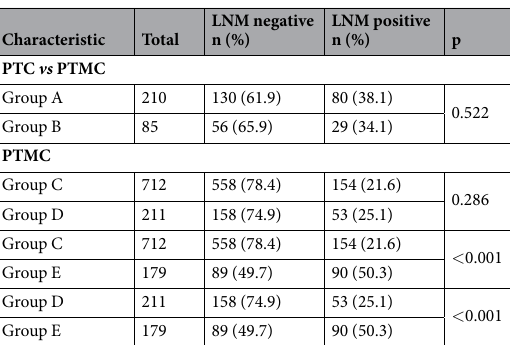
Table 2. Differences in lymph node metastasis between the different tumour size groups. Group A: PTC, unifocal with diameter > 1 cm and ≤ 2 cm; Group B: PTMC multifocal with total tumor diameter (TTD) > 1 cm and ≤ 2 cm; Group C: PTMC unifocal with diameter ≤ 1 cm; Group D: PTMC multifocal with TTD ≤ 1 cm; Group E: PTMC multifocal with TTD > 1